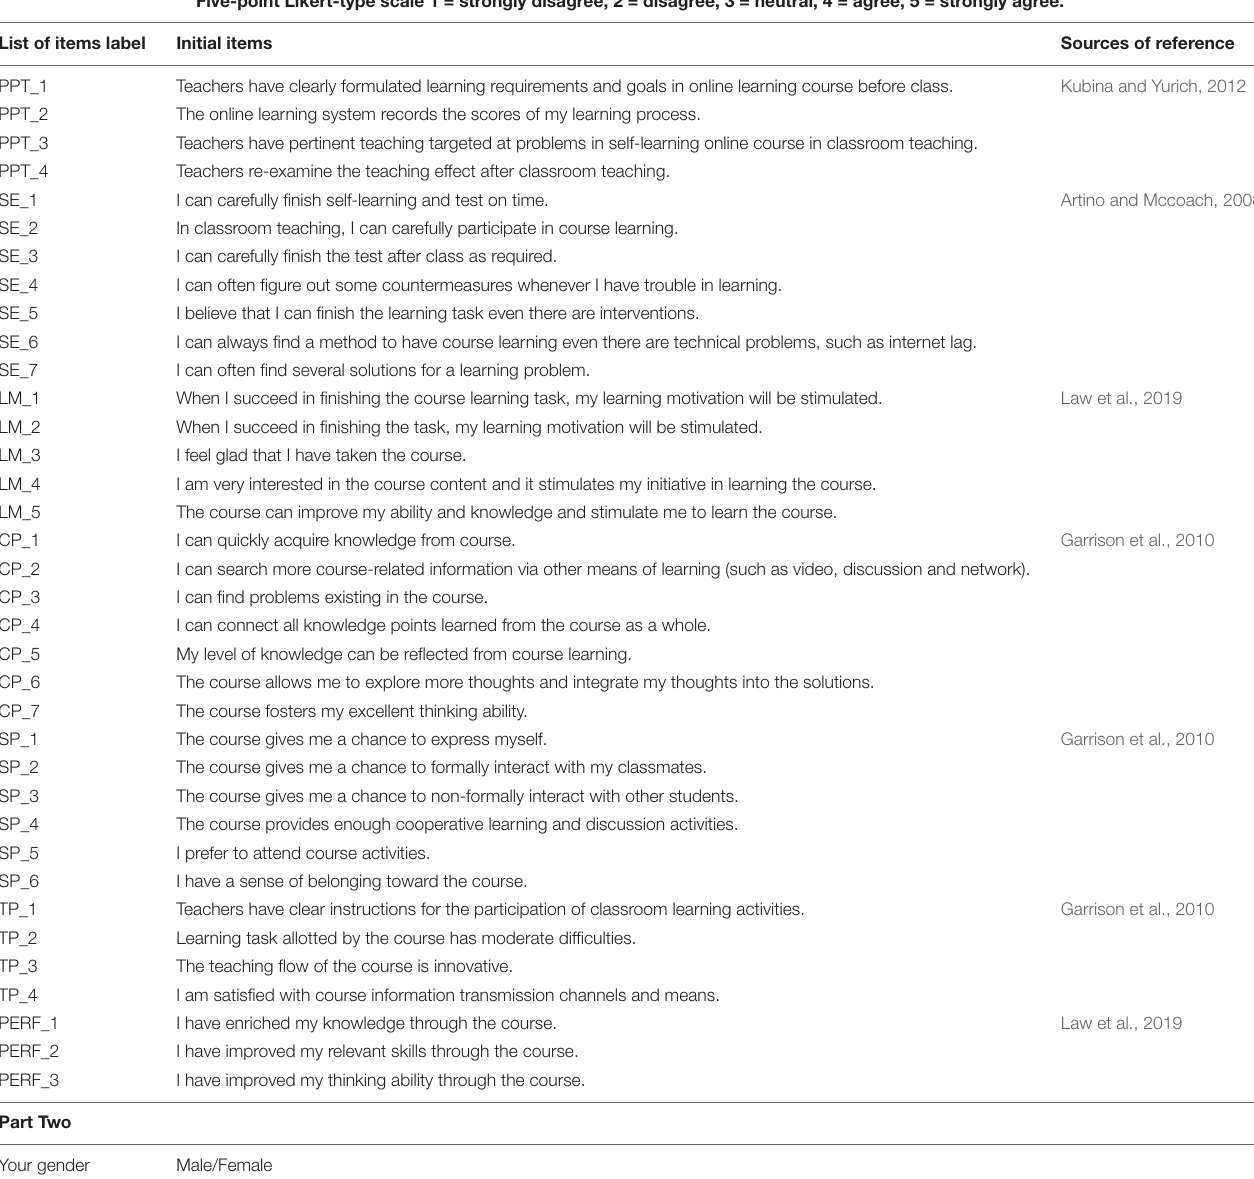
TABLE A1 | Precision teaching survey